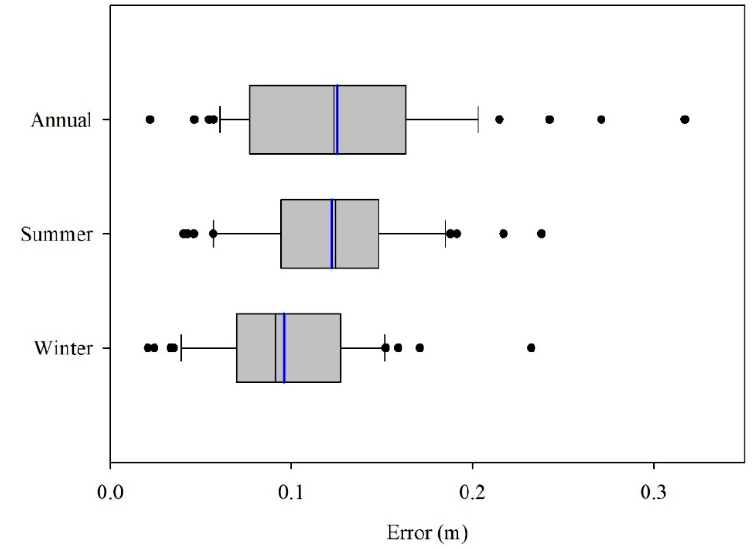
Figure 3. Horizontal errors estimated from the 43 fixed points around the Parlung No. 4 Glacier (shown in Figure 2) with the mean (blue vertical lines) and the medium (black vertical lines) and the quartile to extreme ranges of 25%, 50%, 75% and 90% (black dots) for the cold season (winter), warm season (summer) and annual scale.